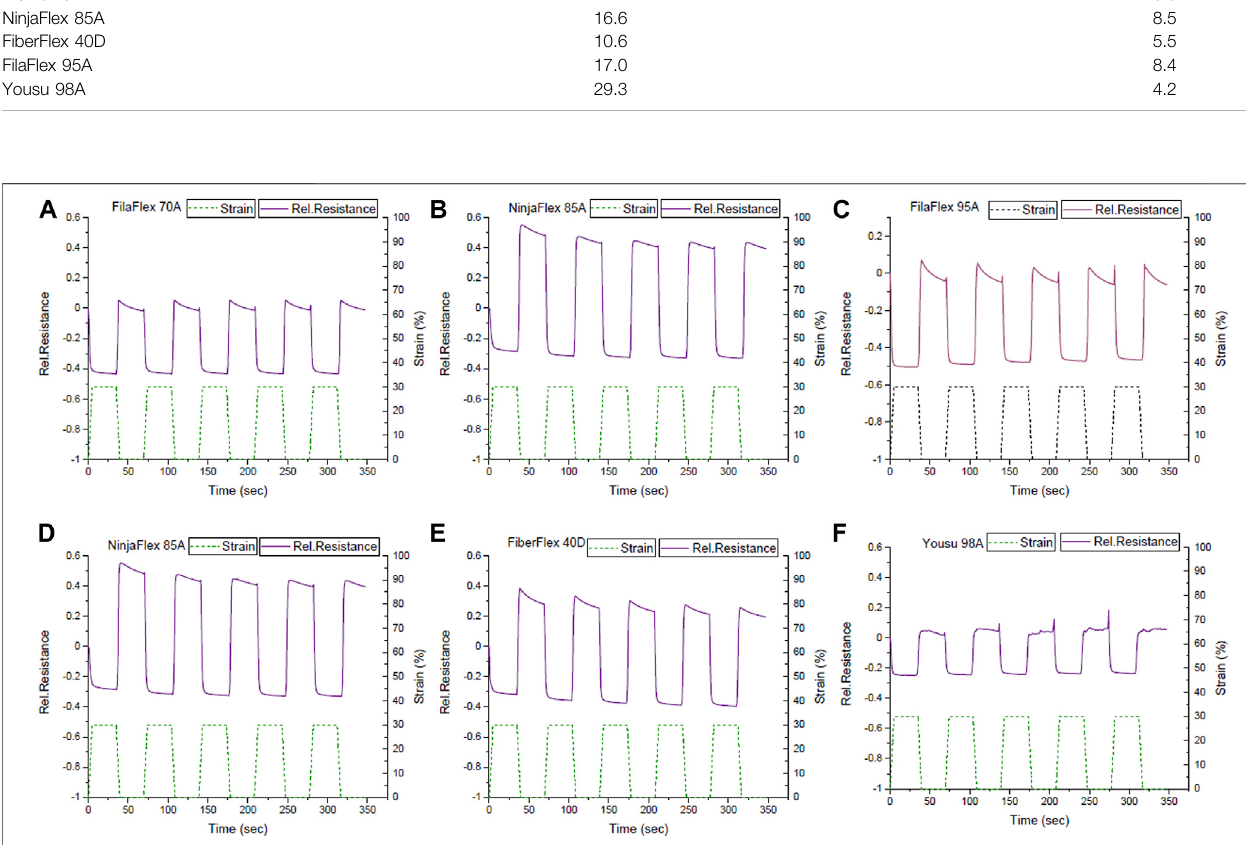
Frontiers in Robotics and AI |